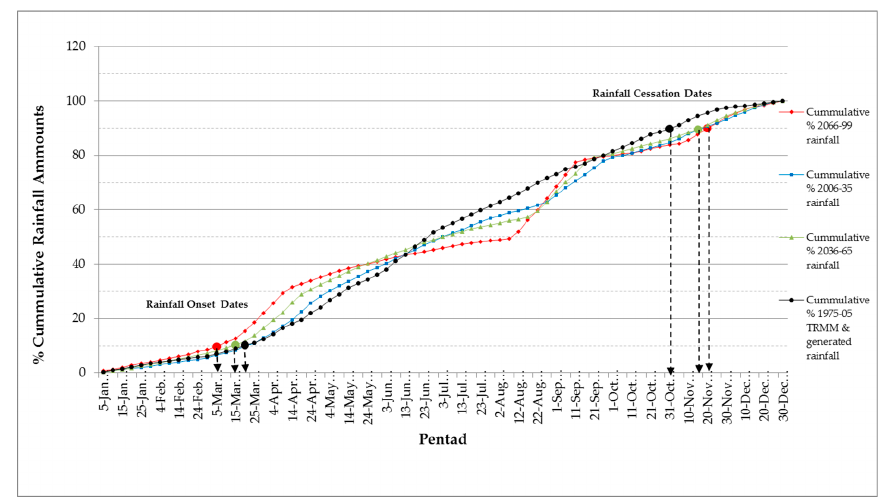
Figure 6. Agago Future Mean Rainfall Onset and Cessation (TRMM Rainfall (1975–2005) and